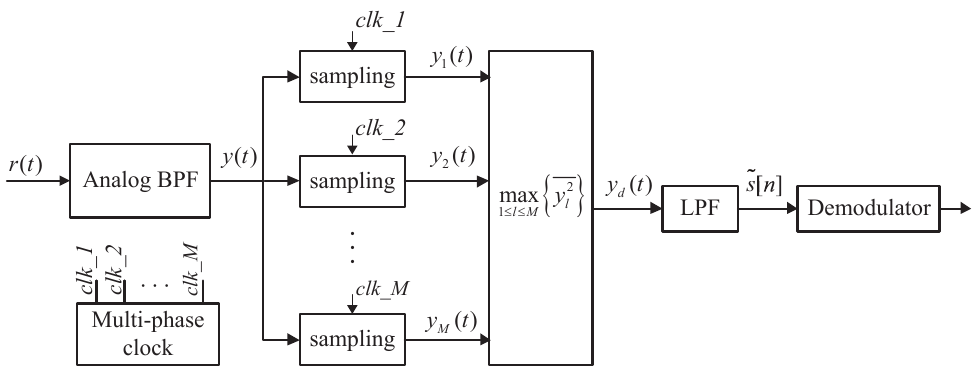
Figure 3. Block diagram of